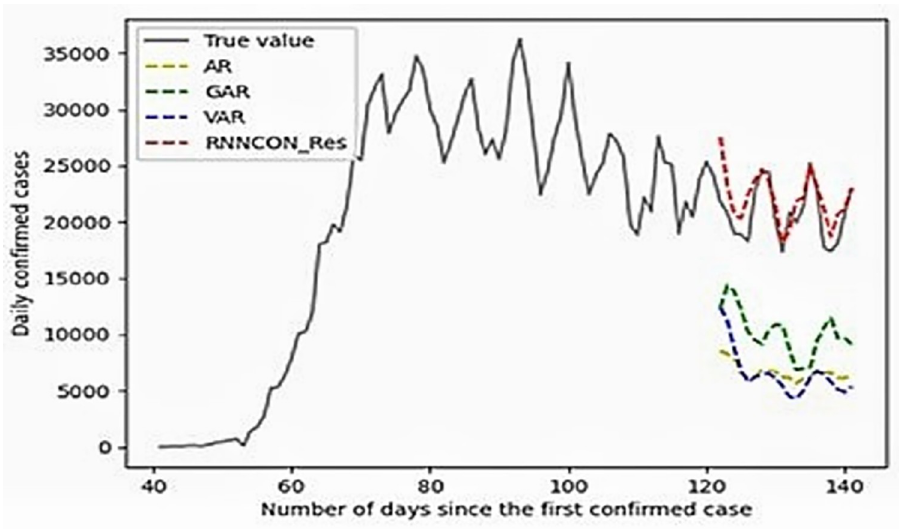
Fig 2. Comparison of the number of covid case predictions using RNNCON-Res and other models.